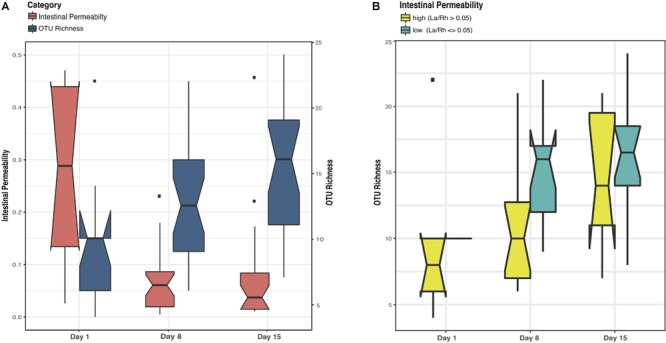
Boxplots comparing levels of intestinal permeability and microbial community diversity at study days 1, 8, and 15 in a cohort of 38 preterm infants (<33 weeks gestational age). Intestinal permeability is measured by non-metabolized sugar probes lactulose (La) (marker of intestinal paracellular transport)/rhamnose (Rh) (marker of intestinal transcellular transport). Microbial community diversity was calculated by OTU (Operational Taxonomic Units) richness. Wilcoxon rank sum test and a false discovery rate of 5% was used in significance test. Median values and interquartile of the values were shown in box. (A) Intestinal permeability (p-value = 0.002) and community diversity at the three study time points (p-value = 0.02). (B) Community diversity (p-value < 0.001) in infants with low and high intestinal permeability defined by a La/Rh > 0.05 or ≤0.05 respectively (Saleem et al., 2017).